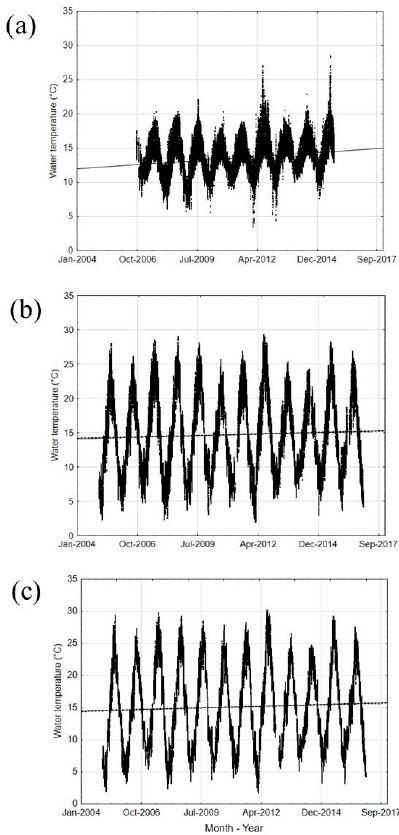
Figure 2. Trend over time of water temperature for 3 automatic monitoring stations: Clitunno River 1 ( a ), Topino River 2 ( b ), Tiber River 3 ( c ). Time periods: 2006–2015 for Clitunno River; 2006–2015 for Topino and Tiber Rivers.